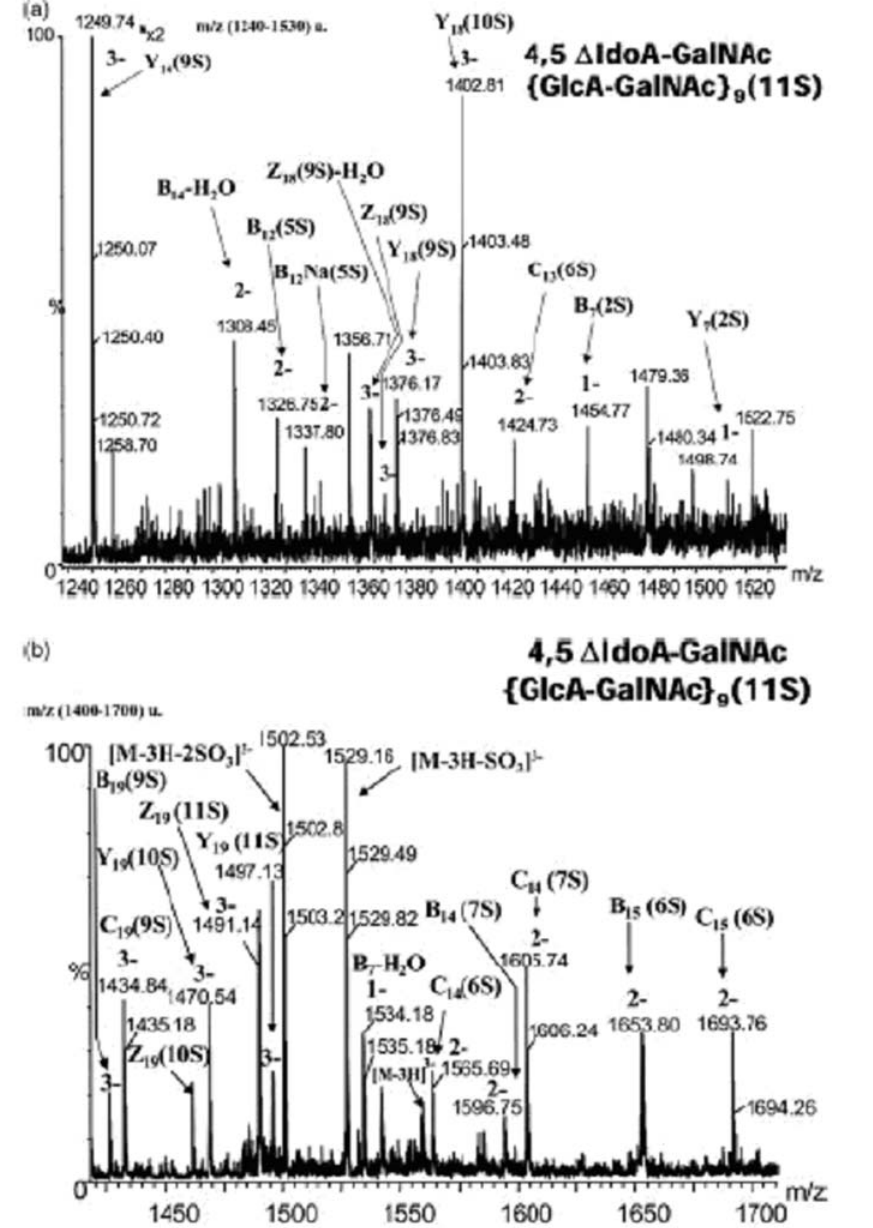
FIGURE 3 Sheathless on-line CE/negative ion mode nanoESI-QTOF-auto MS/MS of the oversulfated unsaturated eicosasaccharide 4,5- Δ -IdoAGalNAc[GlcAGalNAc] 9 (11S) detected as a pentacharged ion at m/z 933.12. (a) m/z (1240–1530) u; (b) m/z range (1400–1700). Assignment of fragment ions is according to Domon and Costello [39]. Reprinted with permission from